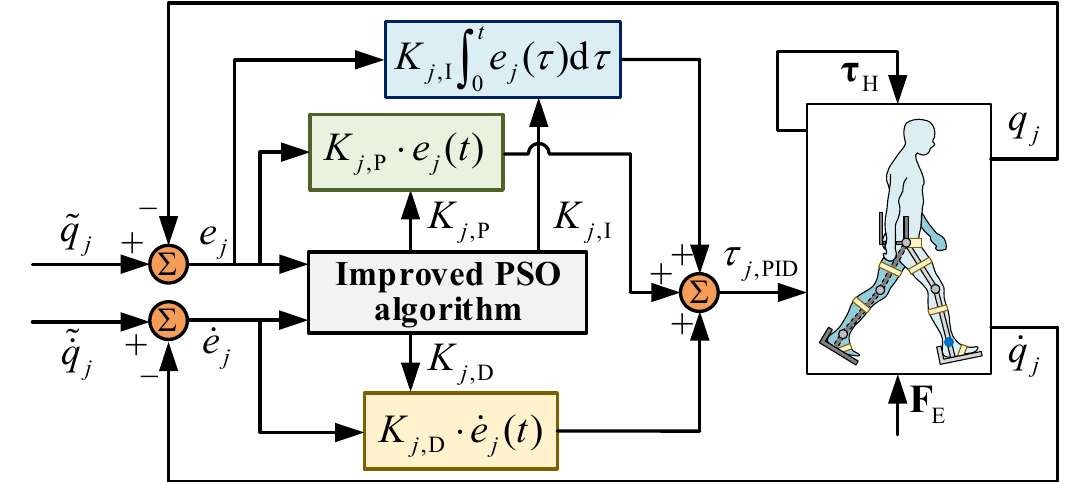
Figure 2. Block diagram of the PSO ‐ based online adaptive PID controller.